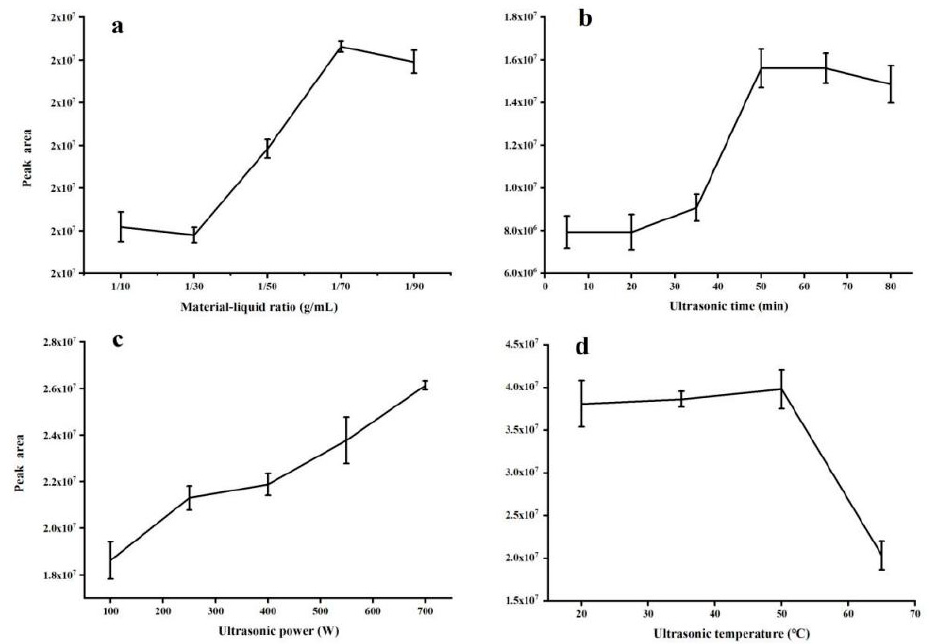
Figure 1. Influence of four parameters on extraction efficiency: ( a ) material-liquid ratio, ( b ) ultrasonic time, ( c ) ultrasonic power, and ( d ) ultrasonic temperature.